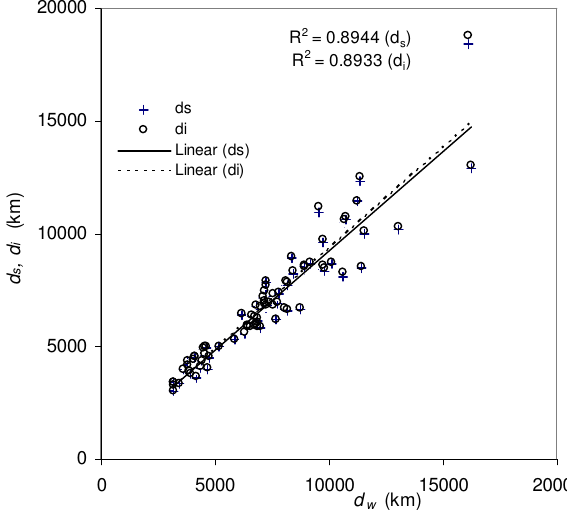
Fig. 9. Correlation of distances d s and d i with d w Figure 9. Correlation of distances d s and d i with d w .